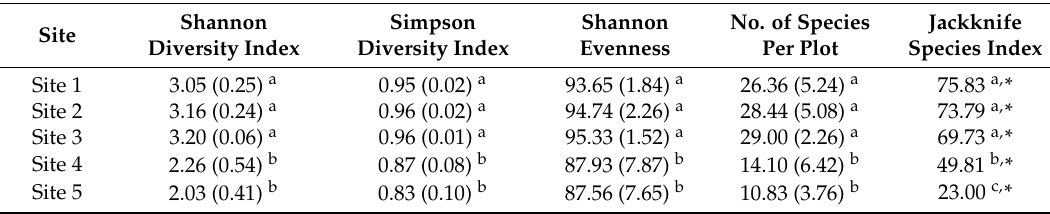
Table 1. Different diversity indices of the five study